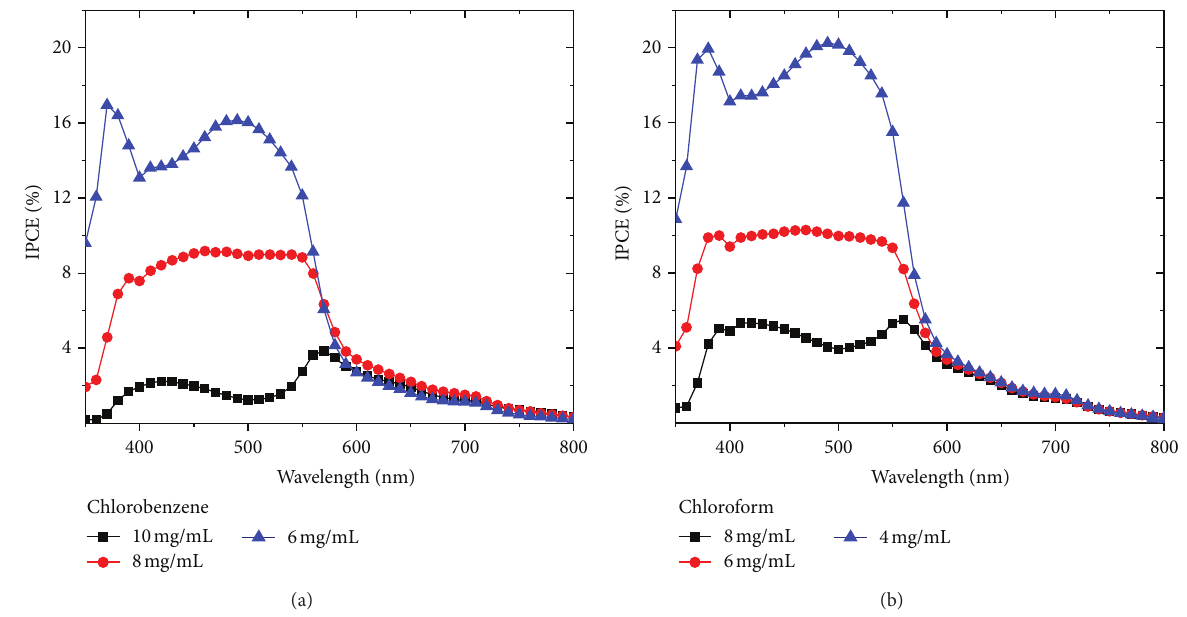
F 4: e IPCE spectra of devices prepared from different CB and CF solution